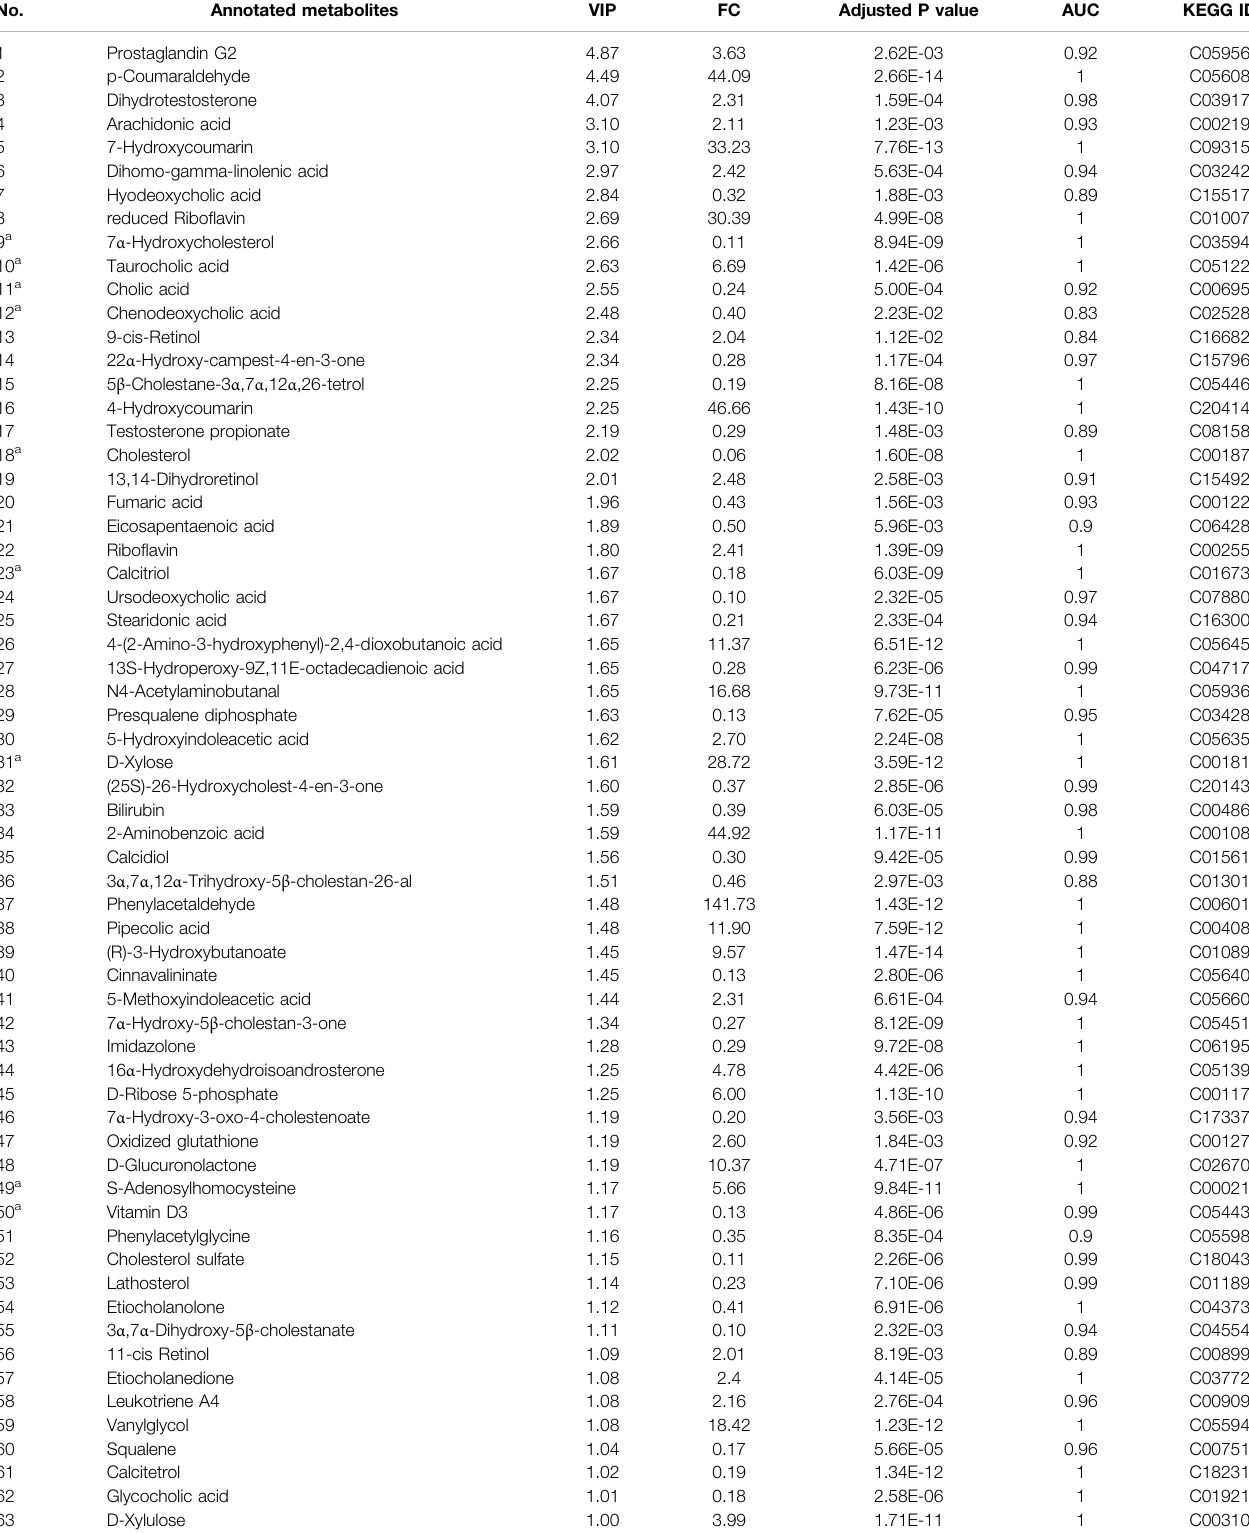
TABLE 1 | Annotated metabolites detected in the rat serum samples after TR administration for 28 days.